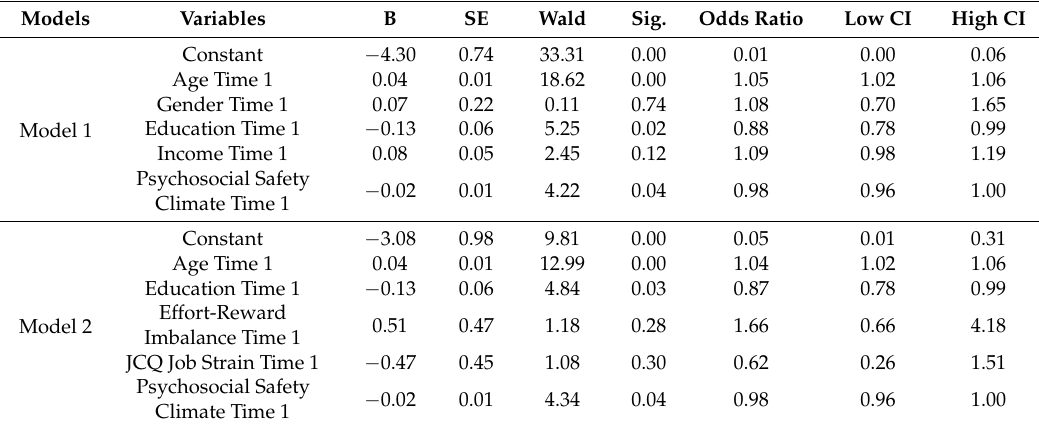
Table 3. Predicting Circulatory Diseases at Time